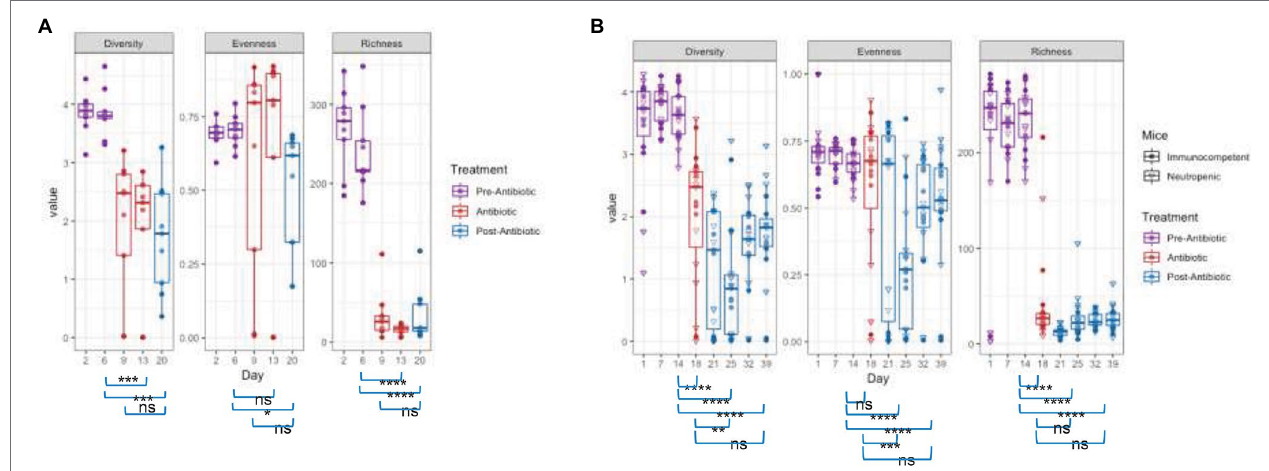
FIGURE 3 | Effect of piperacillin-tazobactam (TZP) on the Alpha Diversity. The alpha diversity of each mouse in each time point was measured using Pielou’s evenness, absolute number of OTUs (richness), and Shannon diversity index (diversity). Significant differences between two time points are indicated by asterisks where p > 0.05 = ns, p < 0.05 = *, p < 0.01 = **, p < 0.001 = ***, and p < 0.0001 = ****. Panel (A) shows results obtained during the TZP1 study, whereas panel (B) displays the results obtained during the TZP2